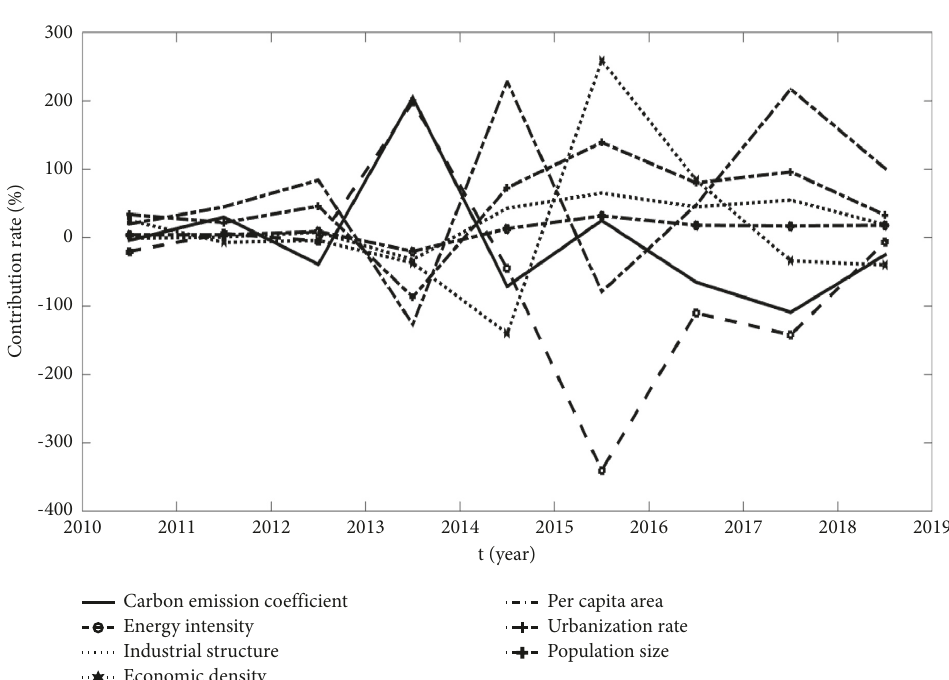
Figure 1: Contributions of various influencing factors to carbon emissions of public buildings during 2010–2019.